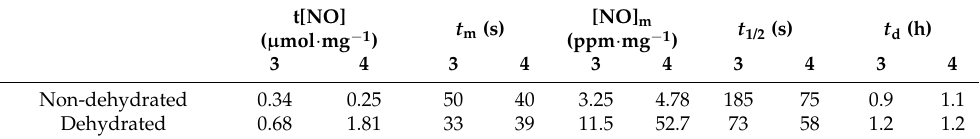
Figure 10. ( a ) Real-time NO release profiles and ( b ) total amount of NO released for NO ⊂ Cu-BTC in deoxygenated PBS (0.01 M, pH 7.4) at 37 °C: sky-blue line, non-dehydrated NO ⊂ micro-Cu-BTC 3 ; blue line, dehydrated NO ⊂ micro-Cu-BTC 3 ; pink line, non-dehydrated NO ⊂ nano-Cu-BTC 4; red line, dehydrated NO ⊂ nano-Cu-BTC 4 . Table 2. NO release properties of NO ⊂ Cu-BTC a,b